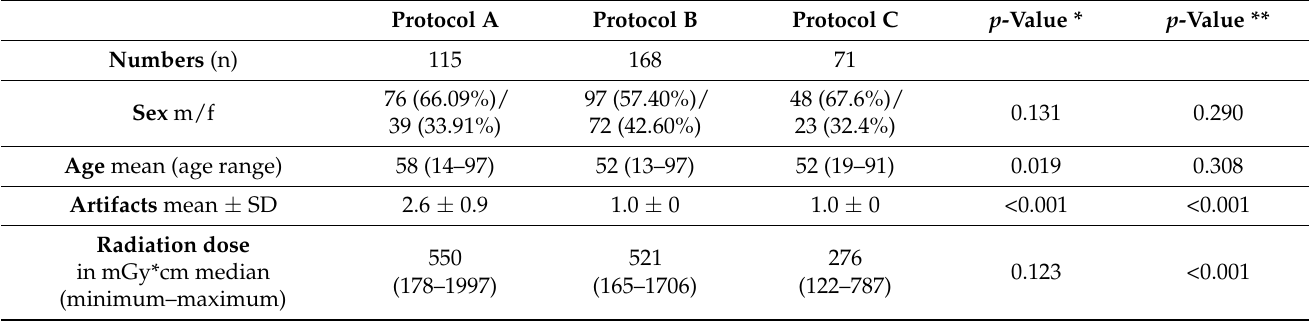
Table 1. Overview of the patient characteristics divided by the three CT protocols examined.